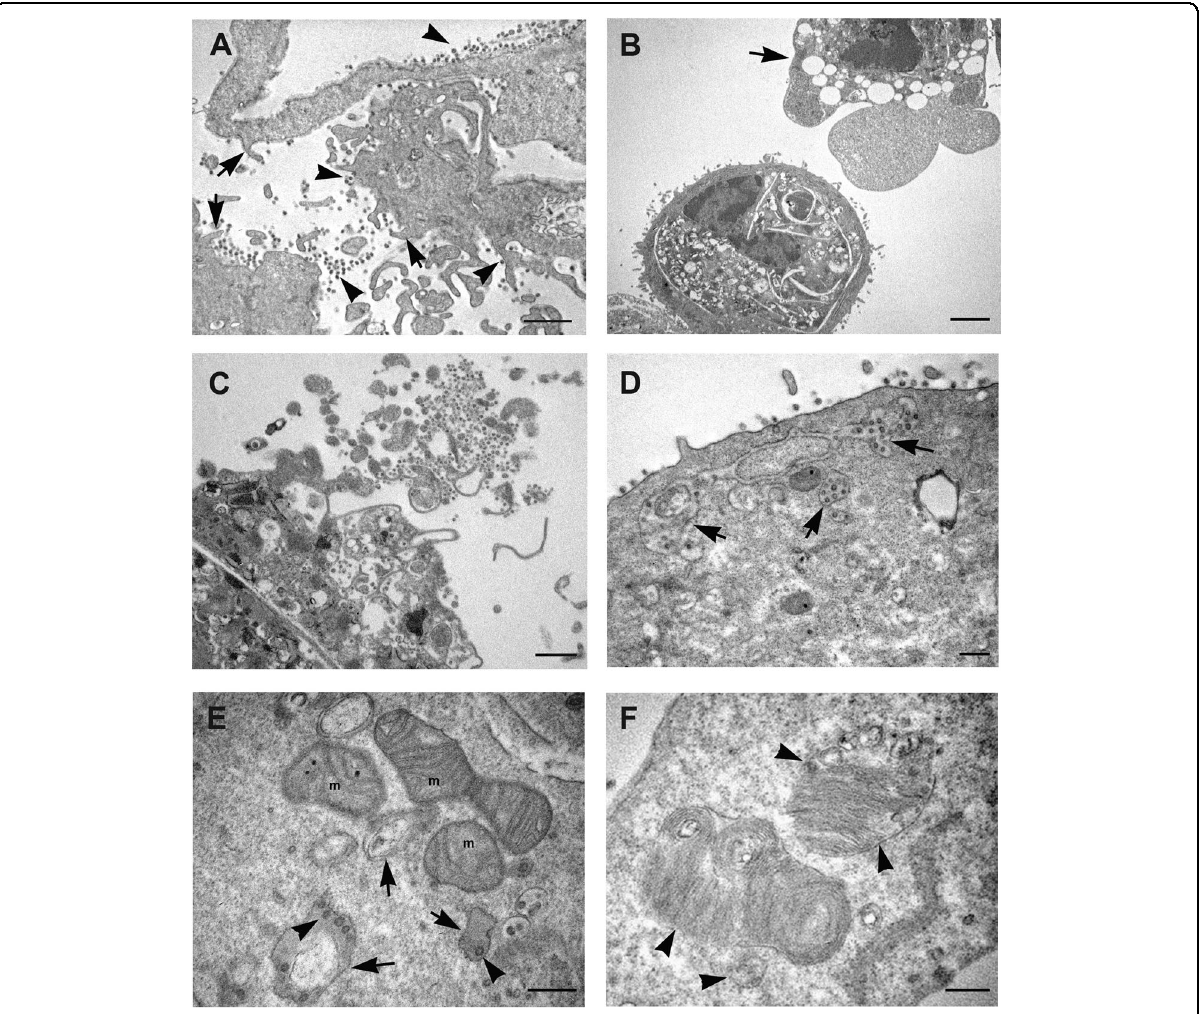
Fig. 3 Electron microscopy micrographs of SARS-CoV-1 infected Vero cells. A Infected cells show a rough aspect, and many microvillous projections are visible all over the cell surface (arrows). Numerous virus particles are visible at the cell membrane or in the extracellular space (arrowheads). B Cytopathic effect of viral infection generates in a number of cells condensation of cytoplasm and apoptotic cell death (arrow). C Cellular lysis with release of cell material with associated virus particles is observed. D Groups of viral particles were found inside vesicles near the plasma membrane of infected cells (arrows). E Morphological modi fi cations of mitochondria (m) are shown, consisting in swelling with a reduction in membrane cristae amount, leading to the formation of vesicles (arrows). Virus particles are visible inside these vesicles (arrowheads). F SARS-CoV-1 infected cells display the presence of multilamellar structure: at the periphery of the structure ribosome-carrying membrane are visible (arrowheads). N nucleus, m mitochondria. Scale bars: A – C = 1 μ m; D – F = 200